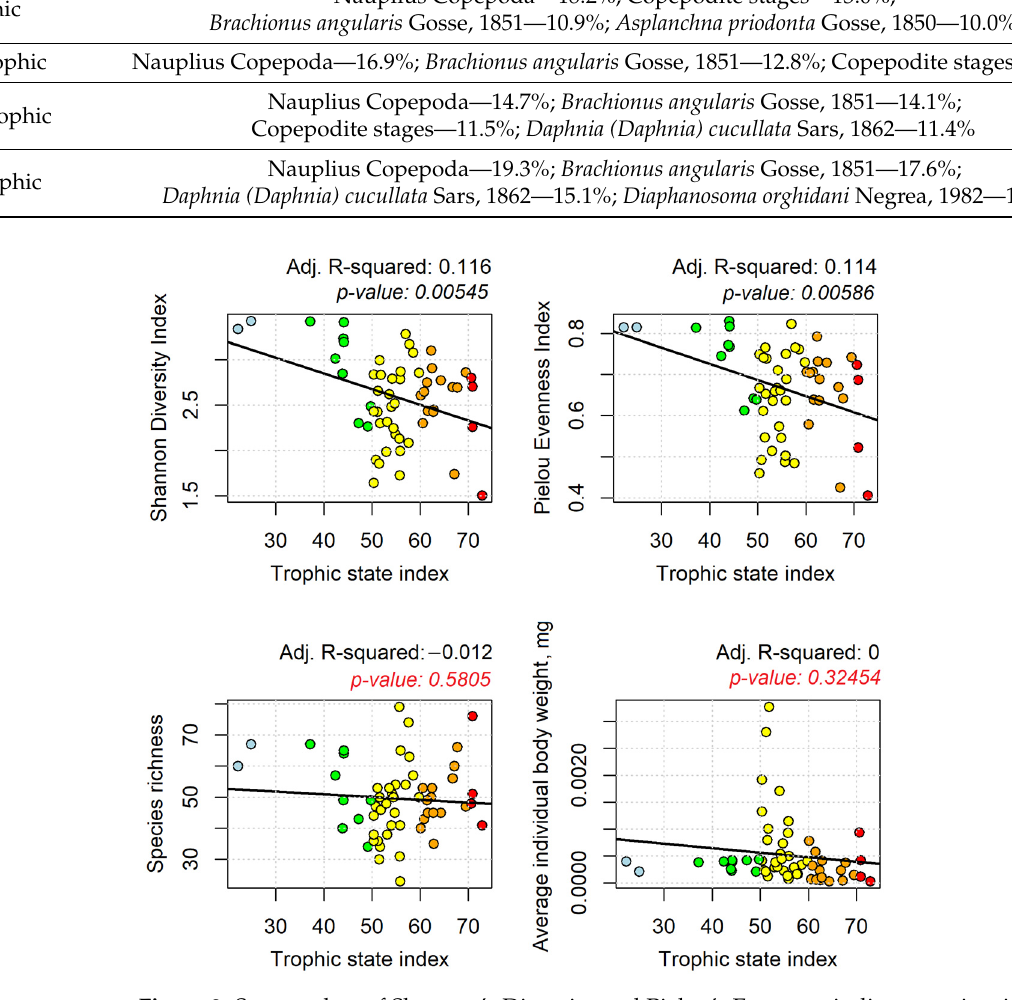
Figure 2. Scatter plots of Shannon’s Diversity and Pielou’s Evenness indices, species richness and average individual body weight for phytoplankton in the river mouth; the solid line indicates the linear regression, color-coding means trophic status (blue—oligotrophic, green — mesotrophic, yellow — slightly eutrophic, orange — medium eutrophic, red — highly eutrophic).